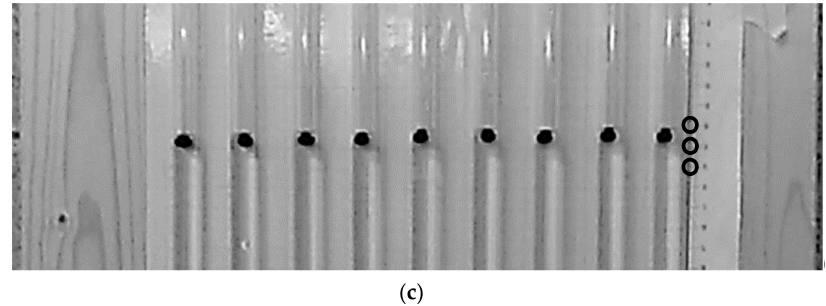
Figure 2. ( a ) An acquired image of the piezometer pipes; ( b ) The image after distortion removal; ( c ) A selected working region within the image with the points (indicated by hollow circles) used to determine the image calibration.